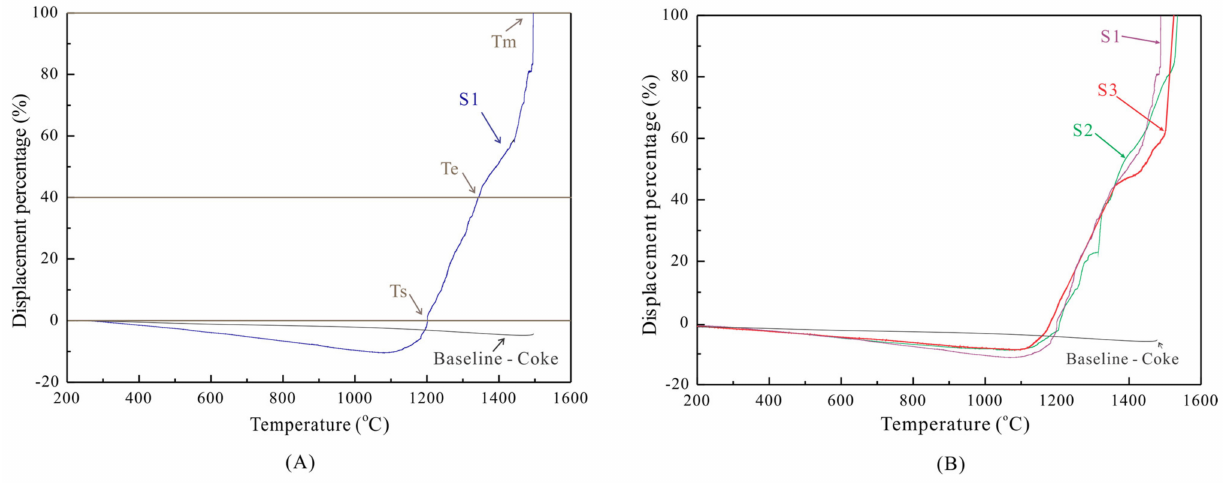
Figure 7. Graph ( A ) indicates the softening and melting temperature at the respective displacement percentage for sinter S1. Graph ( B ) shows the sinter softening and melting behaviour with initial expansion followed by continuous contraction for the three sinters, S1, S2 and S3.